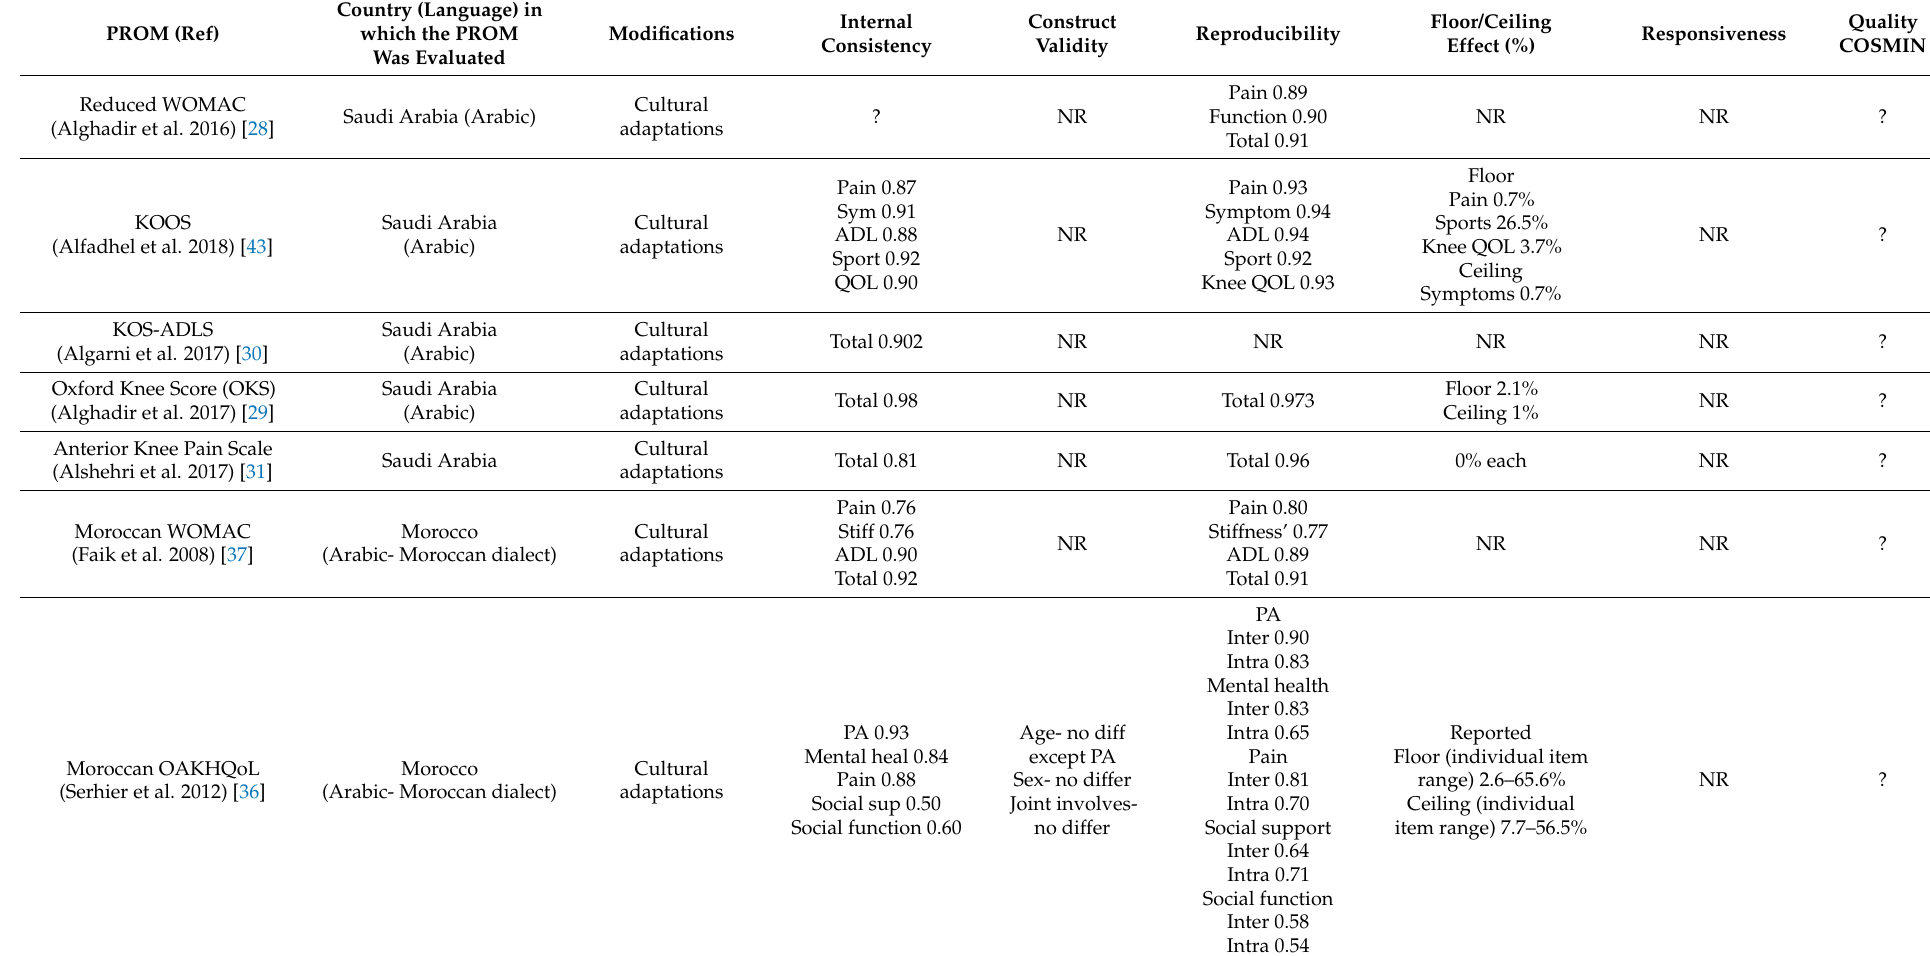
Table 4. Results of studies on measurement of